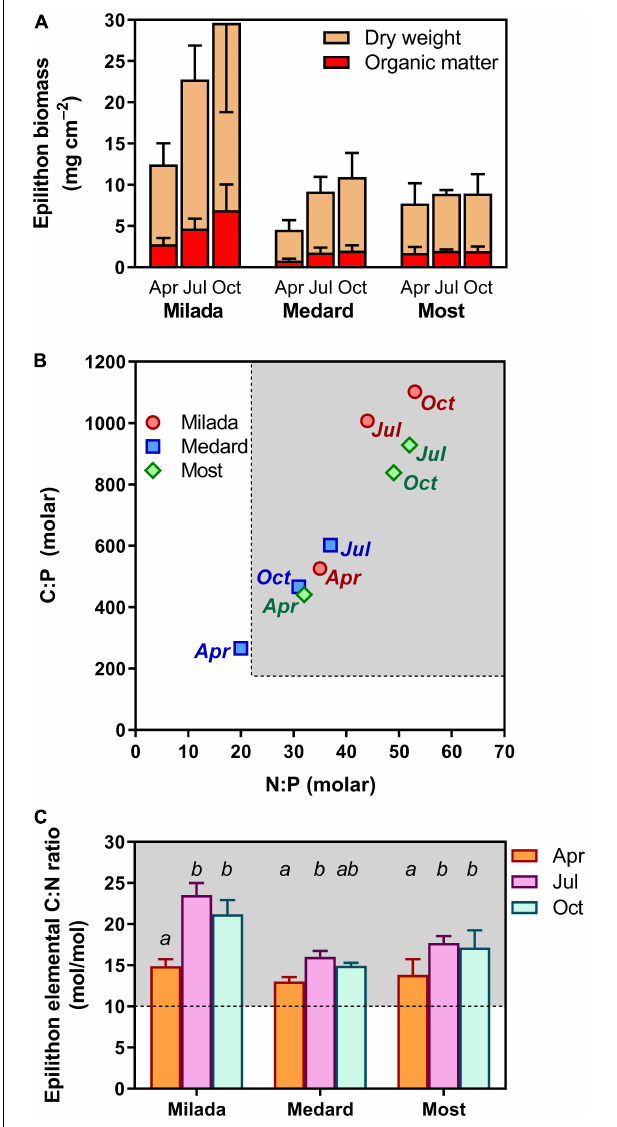
FIGURE 2 | Biomass and elemental composition of epilithon in three post-mining lakes sampled in the Czech Republic in 2019. (A) Epilithon dry weight and organic matter content expressed per overgrown area, (B) relationship between epilithon molar N:P and C:P molar ratios (error bars omitted for the sake of clarity), and (C) epilithon C:N ratios. Columns show averages of 4 (2 × 2) values from two sampling sites and two depths ± SD. Different lowercase letters indicate significant seasonal differences within lakes ( p < 0.05, two-way ANOVA with Tukey’s multiple comparisons post-test). Shaded areas (B,C) show values indicating P and N limitation, respectively, given by Hillebrand and Sommer